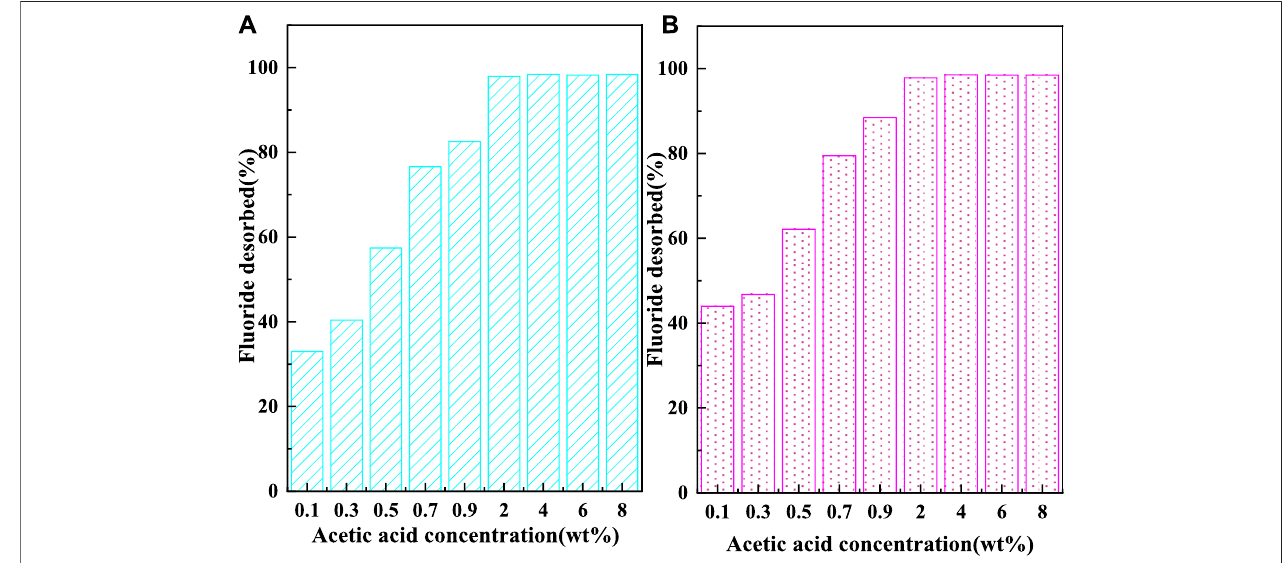
FIGURE 10 | Effect of oxalic acid concentration on the desorption of fl uoride about C-SAA and C-SAAoa.